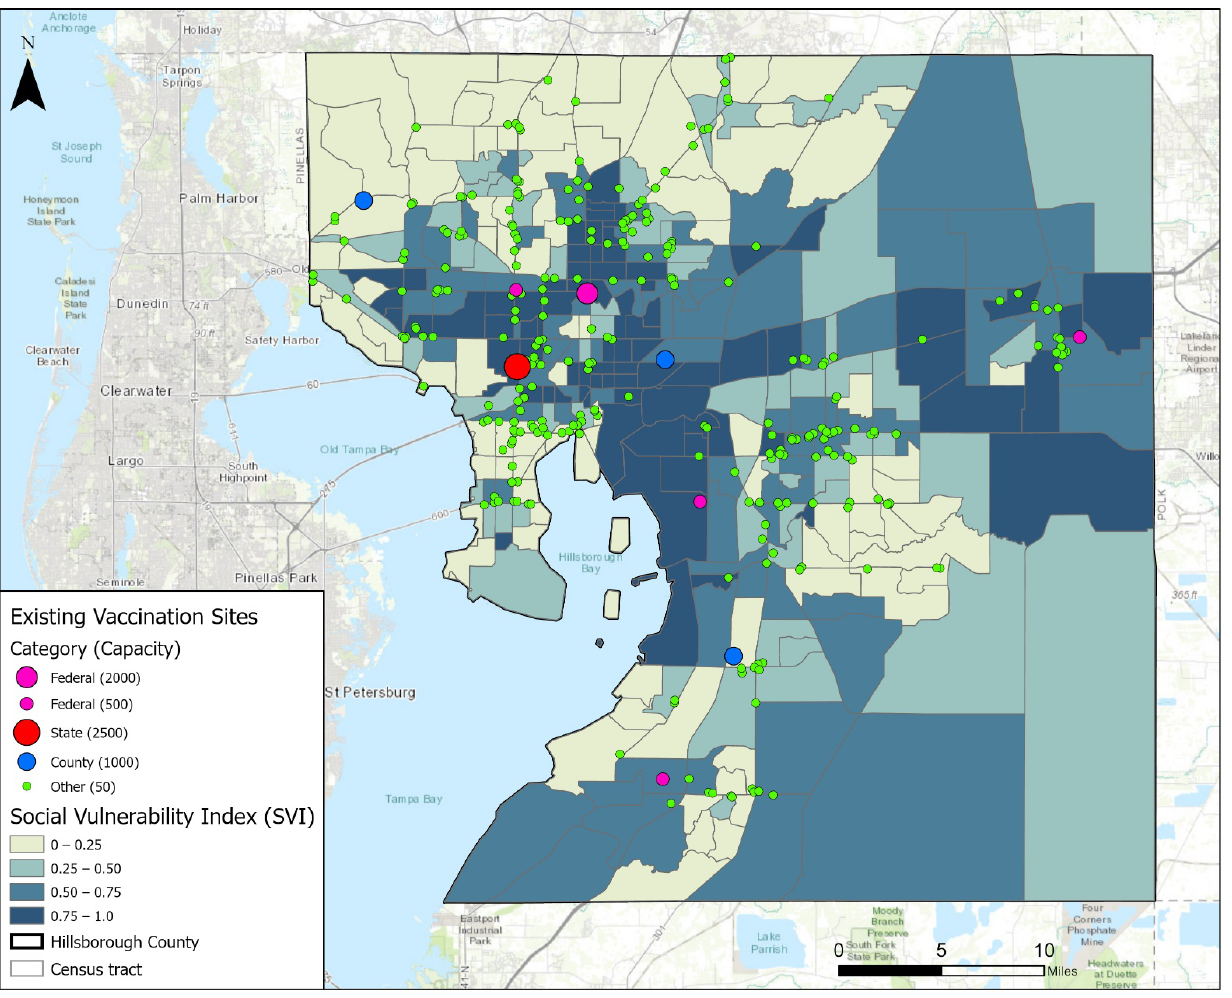
Figure 1. Existing vaccination sites in Hillsborough County, Florida.